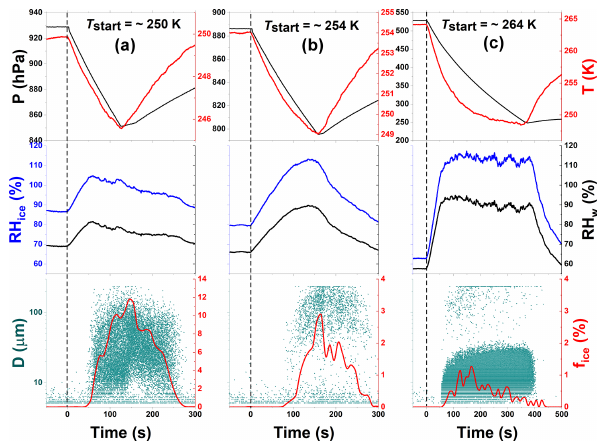
Figure 4. Freezing experiment data for processed CFA_UK parti- cles at 250, 254, and 264K start temperatures ( T start ) . These data correspond to experiments 9, 10, and 11 in Table 2, respectively. Processing involved the intermediate cooling of the particles to 228K (see Fig. 2). The individual panels contain the same data types as in Fig.